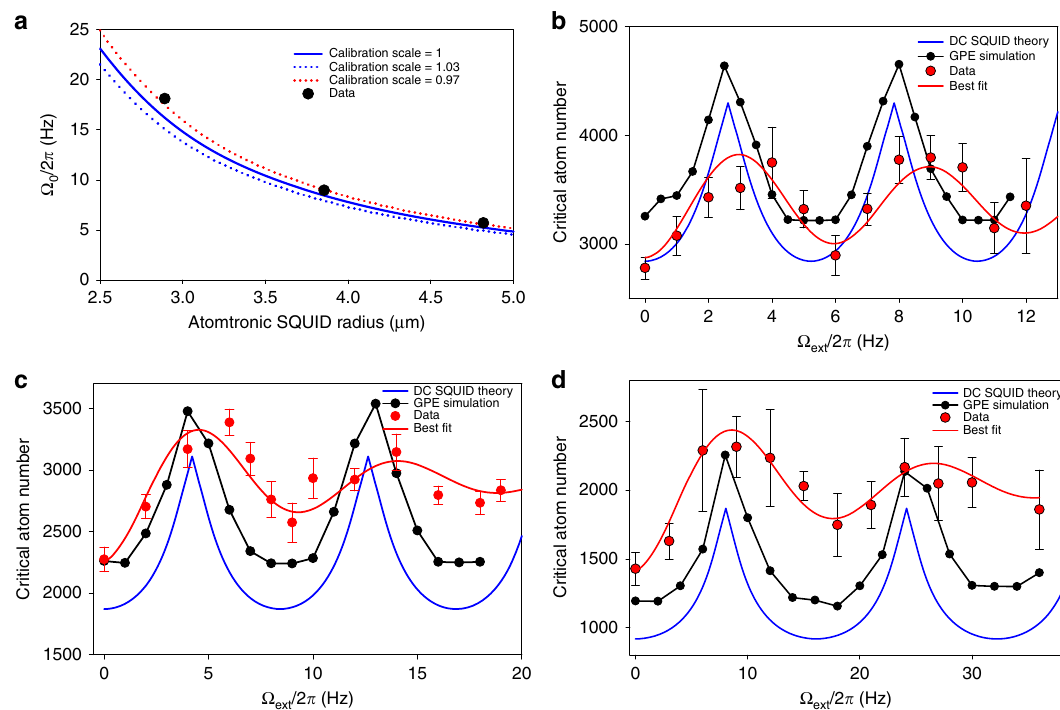
Fig. 4 Comparison between experiment and theory. The error bars in the plots represent the standard error. a Comparison of the measured and calculated values of Ω 0 /2 π (calculation done using GPE). The three curves correspond to calibration scales of the atomtronic SQUID radius. b – d Critical atom number as a function of the rotation rates obtained with GPE simulation and DC SQUID theory, along with the measured data and the best fi t. For b , the radius is 4.82 µ m; for c , the radius is 3.85 µ m; and for d , the radius is 2.891 µ